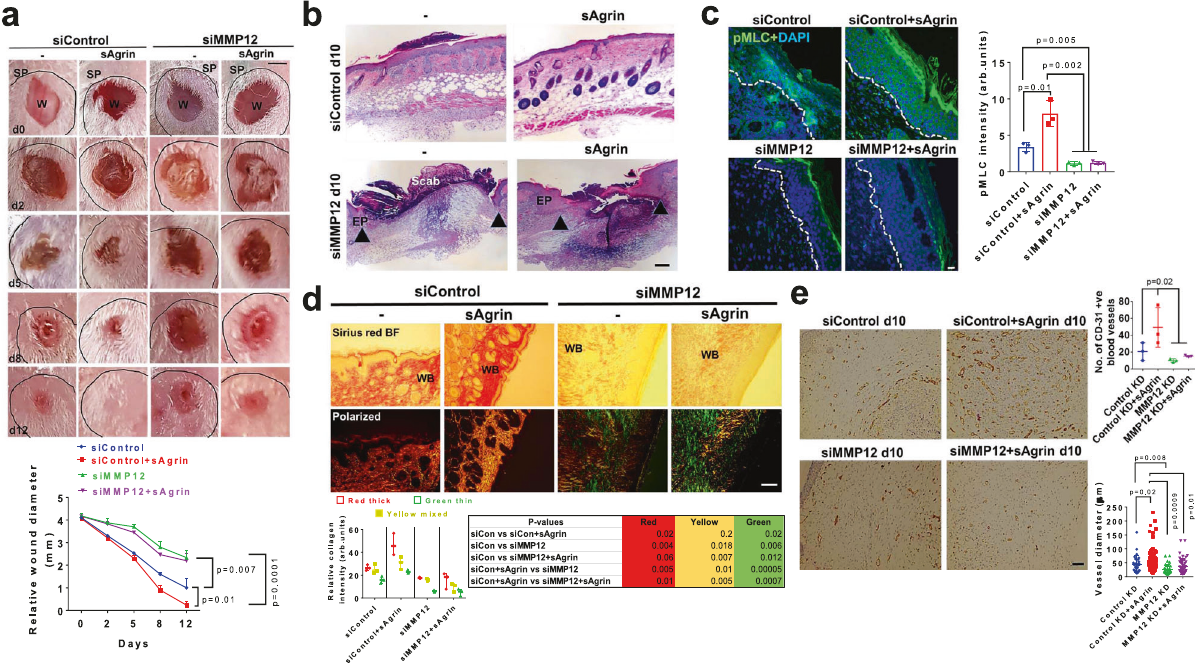
Fig. 6 MMP12 is required for sAgrin-induced wound healing in vivo. a Representative photographs of control or MMP12 silenced splinted mouse skin wounds at indicated days either untreated or treated with 200 μ g of sAgrin. Scale: 1mm. The wound diameter at indicated days is quanti fi ed as mean + / − s.e.m. ( n = 3 mice per group, two-way ANOVA, * p = 0.007, * p = 0.01, *** p = 0.0001, respectively). SP indicates splint. b Representative Haematoxylin and Eosin stained sections of mouse skin receiving the combinations of siRNA treatments as in panel ( a ) at day 10 post-wounding. Region encoded by black arrows represents the unhealed area ( n = 3 sections from three mice per condition, repeated twice). Scale: 100 μ m. c Representative confocal images showing the pMLC staining in control and MMP12 depleted mouse skin in the absence or presence of sAgrin treatments. Scale: 10 μ m. The pMLC intensity was quanti fi ed as mean + / − s.d. ( n = 3 mice sections per group, two-tailed Students ‘ t ’ test, * p = 0.01, ** p = 0.005 and 0.002, respectively). d Picrosirius red staining images of indicated mouse skin sections at day 10 post-wounding. Representative bright- fi eld and polarized views are presented. Scale: 100 μ m. WB denotes wound bed. The collagen fi bers distribution was presented as mean + / − s.d. ( n = 3 sections per group, two-tailed Students ‘ t ’ test, p values presented in the table). e Assessment of angiogenesis by CD-31 immunohistochemistry in control and MMP12 de fi cient mouse skin wound beds in the presence or absence of sAgrin treatment at 10 days post-injury. The number of blood vessels and their diameter are represented as mean + / − s.d. ( n = 3 mice per group, at-least 30 blood vessels from each image from three mice per group were analyzed, One-way ANOVA, * p = 0.02, two-tailed Students t-tests, * p = 0.02, p = 0.01, p = 0.008, ** p = 0.0009, respectively). Scale: 100 μ